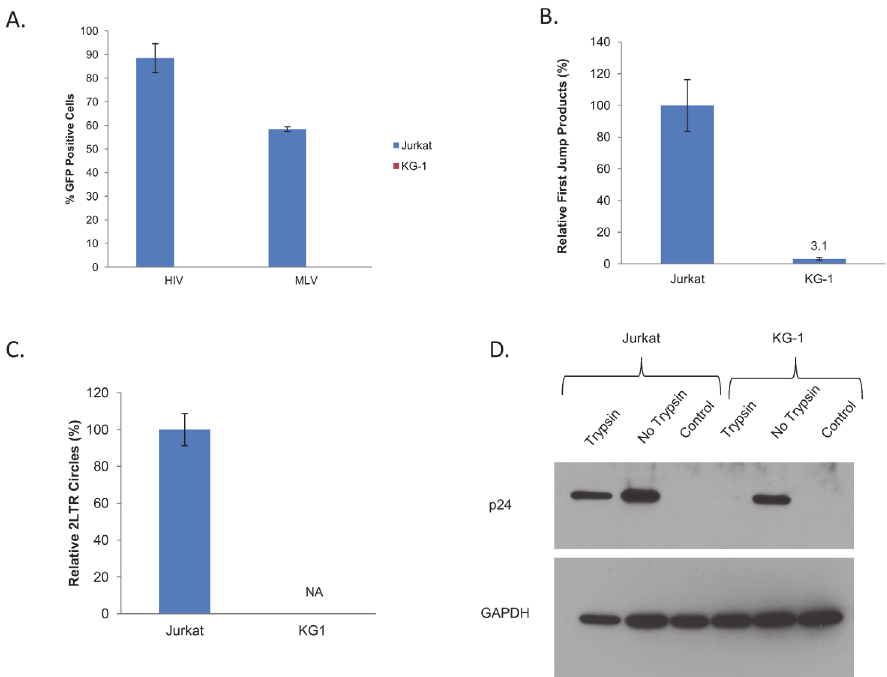
Fig 5. RD114 mediated entry defect in KG-1 cells. (A) Jurkat and KG-1 cells were infected with RD114 pseudotyped HIV-1 (MOI = 5) and MLV (MOI = 1) encoding EGFP. Percentage of EGFP positive cells were determined using fluorescence cytometry 3 days post infection. Data are from 3 independent experiments and error bars represent standard deviations of the mean. (B) KG-1 and Jurkat cells were infected with RD114 pseudotyped HIV-1 at an MOI of 1 and viral cDNA products were quantified using qPCR for first jump products 8 hours post infection and (C) for 2LTR circles at 48 hours post infection. Data are from triplicate samples and are representative of three independent experiments. Errors bars represent standard deviations of the mean; NA — no amplification. ( D) KG-1 and Jurkat cells were infected with RD114 pseudotyped HIV-1 at an MOI of 5. Cells were collected at 2 hours, washed, treated with Trypsin-EDTA or not and the lysates were used for immunoblotting with the indicated antibodies. Control indicates non-infected cells. The blot is representative of three independent